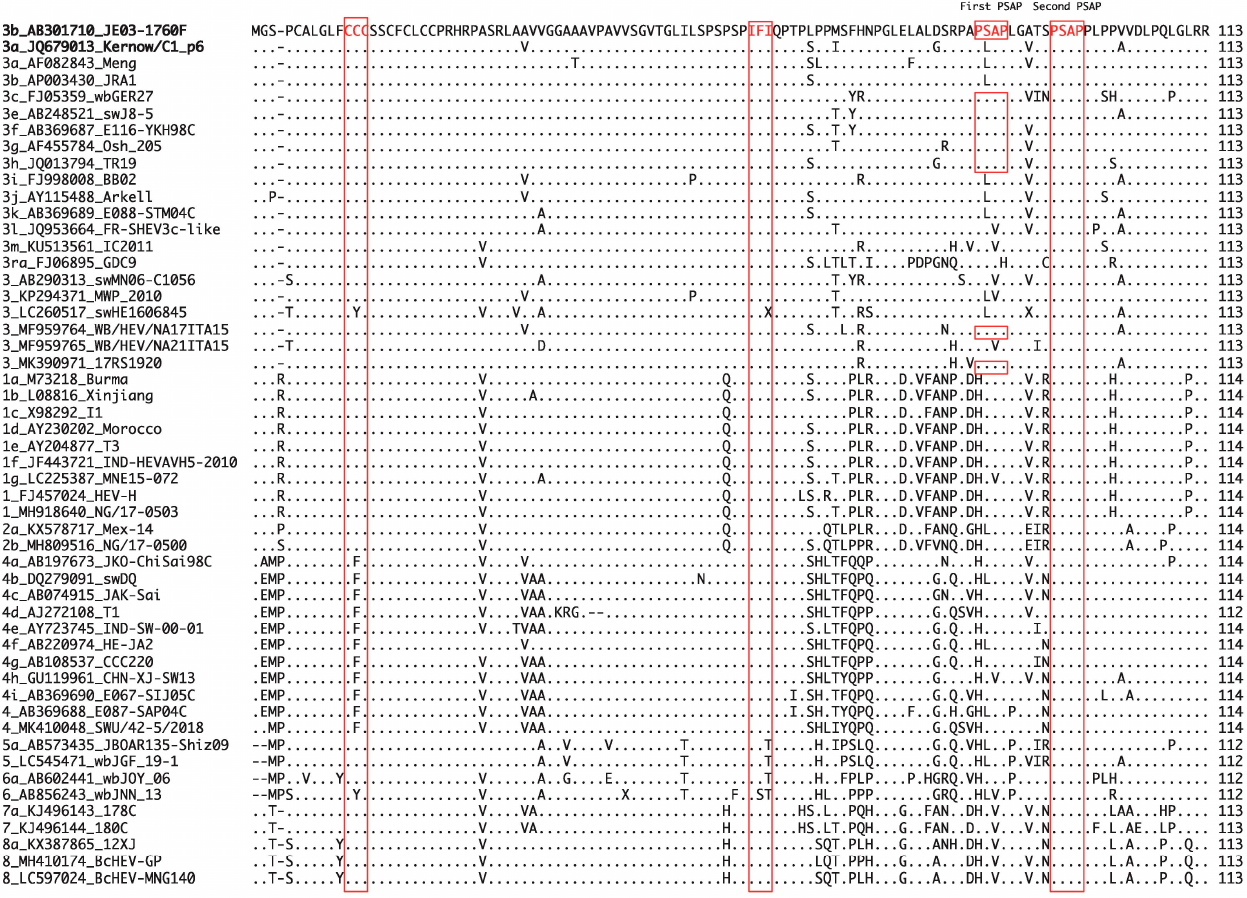
Figure 3. Alignment of the ORF3 amino acid sequences of Orthohepevirus A species showing the conserved PSAP motifs and CCC and IFI motifs. The PSAP motifs are known to be essential to the promotion of virion release [33], and the CCC and IFI motifs are reported to facilitate the virus release and ion fluxes [34].